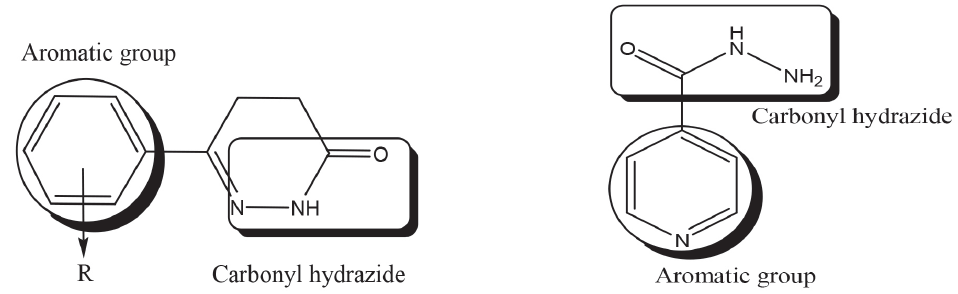
FIGURE 1 - Structure similarities of Aryl-pyridazinone compounds and anti-TB drug